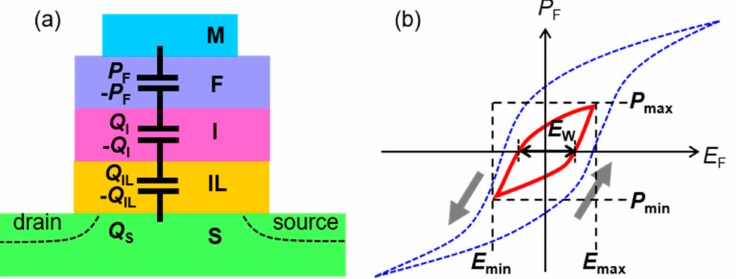
Figure 2. ( a ) Schematic cross-section of a FeFET with an equivalent circuit of MFI(IL)S gate stack. For convenience of explanation, the circuit is represented using virtual capacitances instead of a strict physical explanation by the electric flux density continuity, D . ( b ) Schematic drawings of P F versus E F . All P F - E F loops are drawn in counter-clockwise directions. The inner loop (red solid) is a minor loop corresponding to unsaturated P F discussed in Section 2.2. Outer loop (blue broken) is a major loop for saturated P F added as a reference. Every loop has its P max at E max and P min at E min